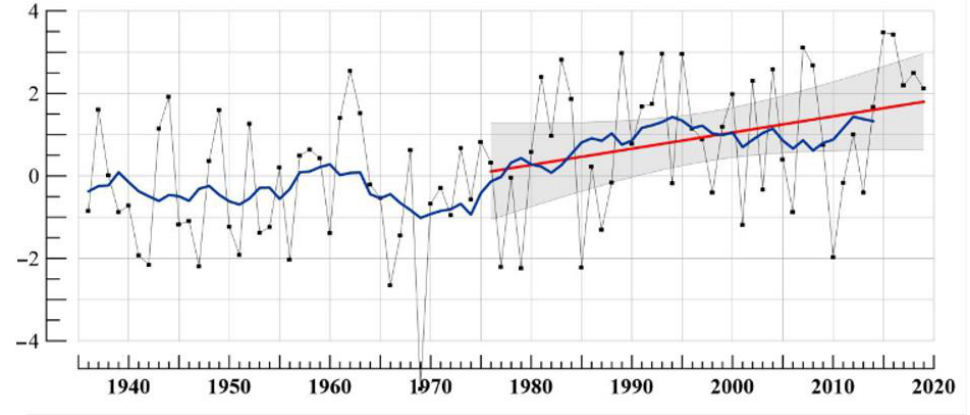
Figure 2. Mean annual surface air temperature (MAAT) anomalies average for Russia. Source [31].